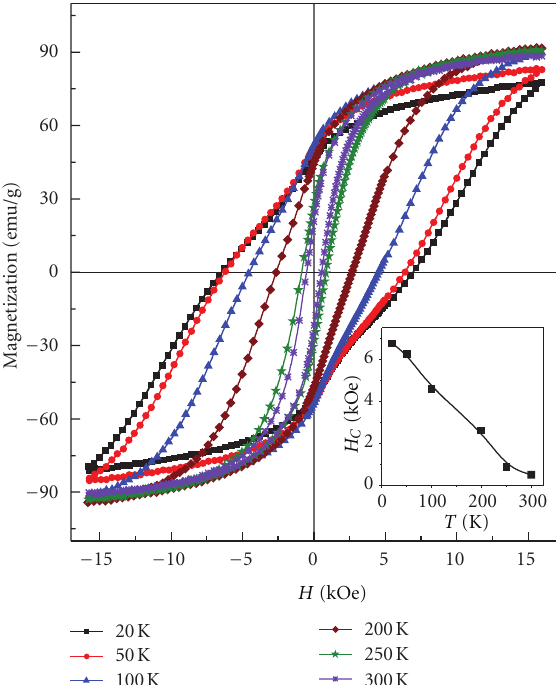
Figure 3: Magnetic hysteresis of as-prepared CoFe 2 O 4 –Fe 2 O 3 mag- netic nanocomposites obtained at di ff erent temperature between 20K and 300K. Inset: Variation of coercivity with temperature.